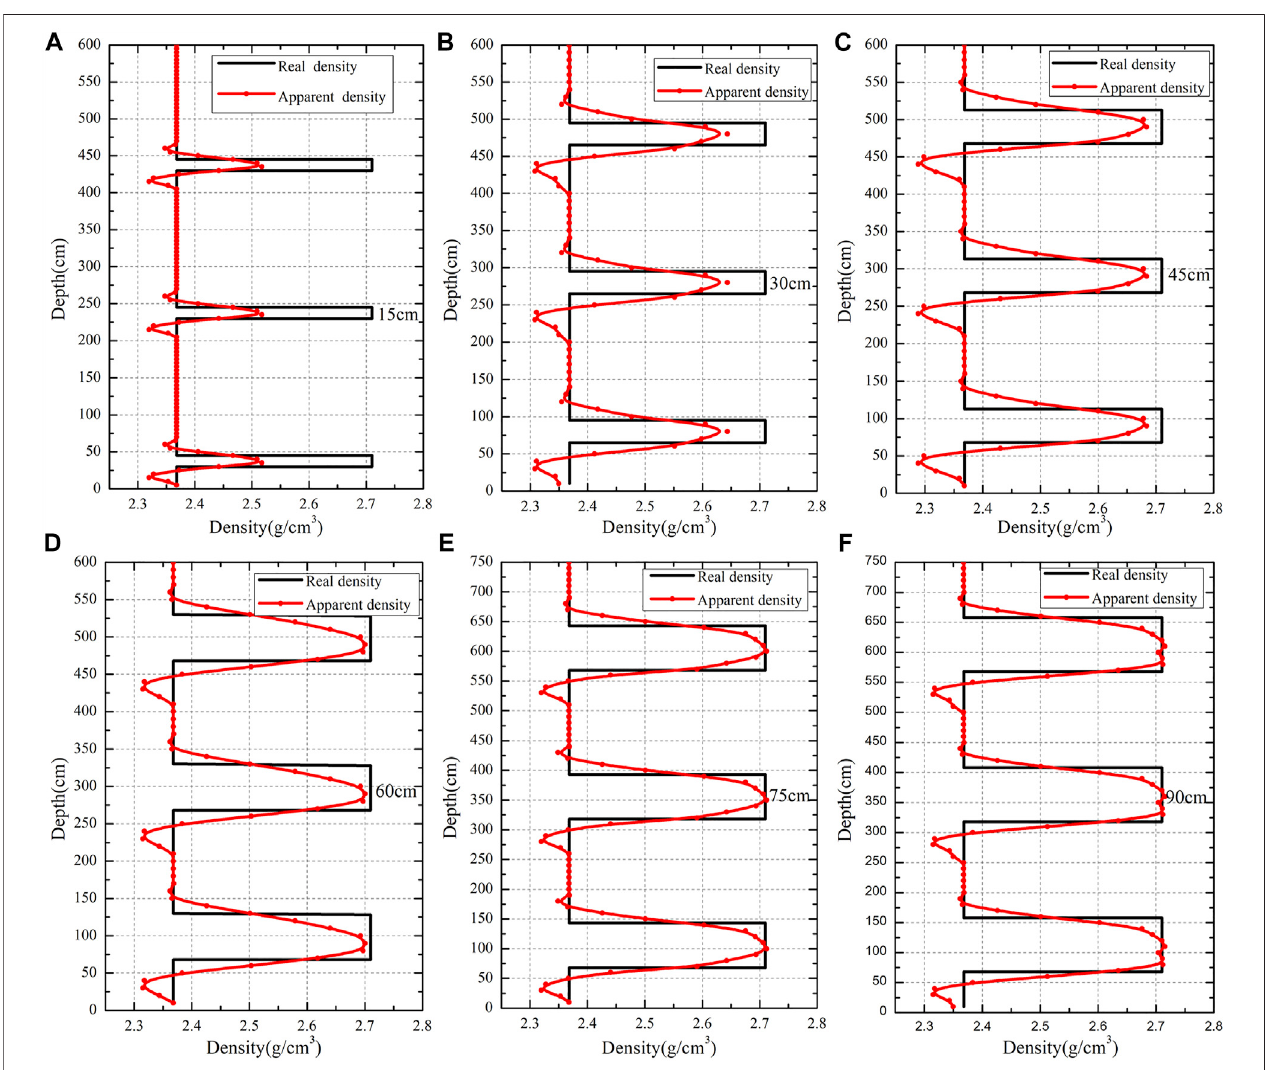
FIGURE 11 | Vertical resolution of the neutron-gamma density tool in a vertical well. The background formation is a 20 P.U. limestone formation fi lled with freshwater, andthemeasuredlayerisa0 P.U.limestoneformation (A) thickness ofthe thinlayersis15 cm; (B) thickness ofthethinlayersis30 cm; (C) The thicknessof the thin layers is 45 cm; (D) thickness of the thin layers is 60 cm; (E) thickness of the thin layers is 75 cm; (F) thickness of the thin layers is 90 cm.